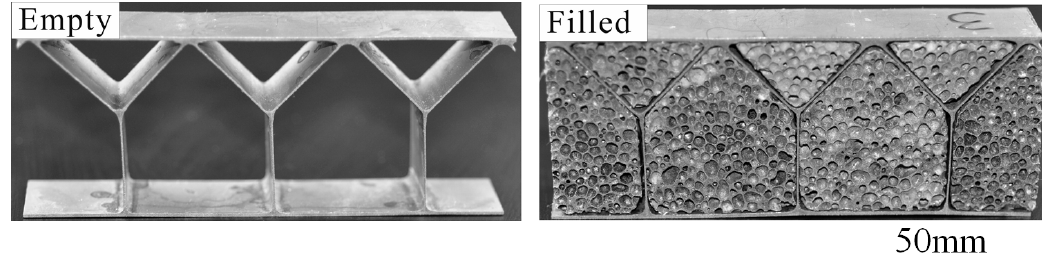
Figure 2. Specimen images of empty and aluminum foam-filled Y-shape cored sandwich panel, t = 0.41 mm.